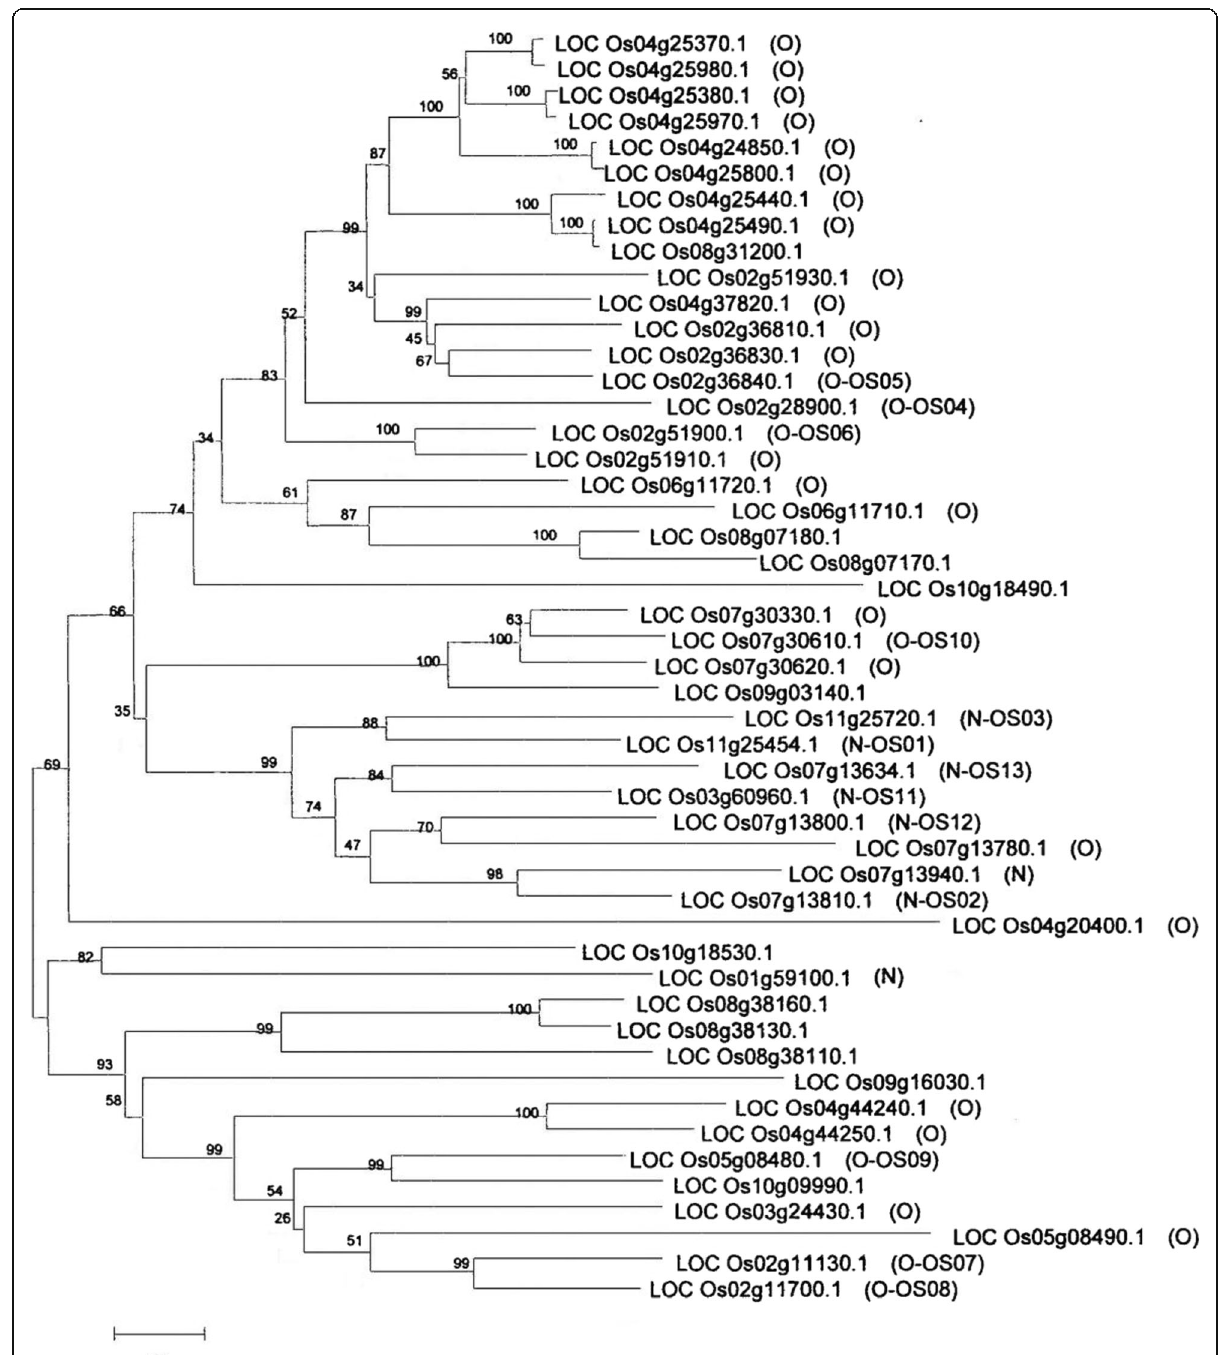
Fig. 2 Rice cytokinin glycosyltransferase phylogenetic tree. The phylogenetic tree was constructed using MEGA software based on the similarity information of these